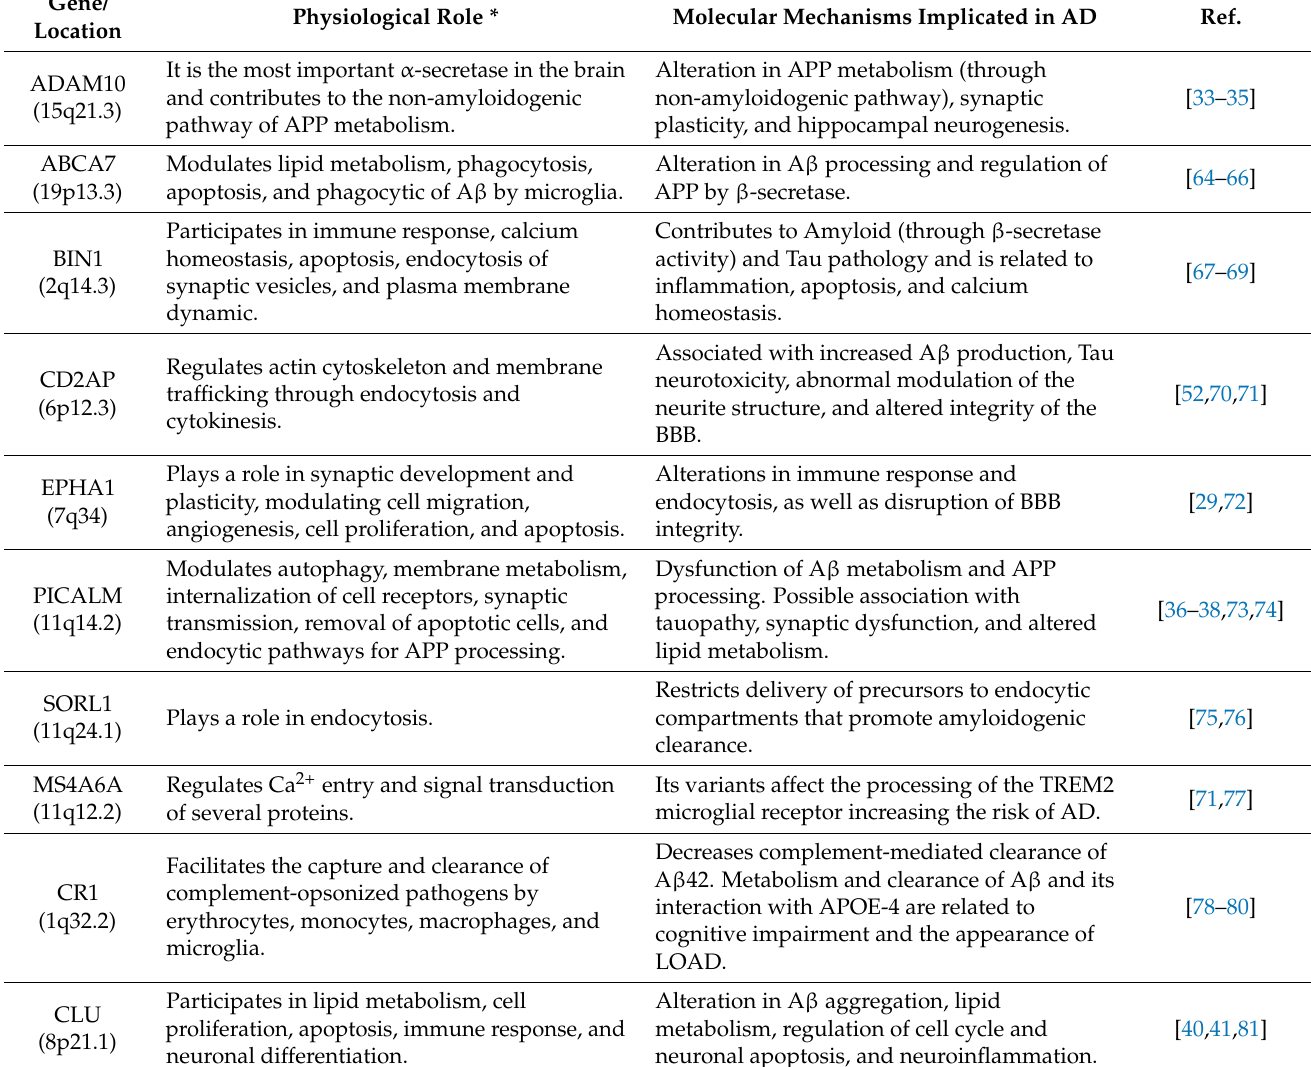
Table 1. New genes linked to Alzheimer’s disease and their physiological and pathological roles. Molecular Mechanisms Implicated in AD